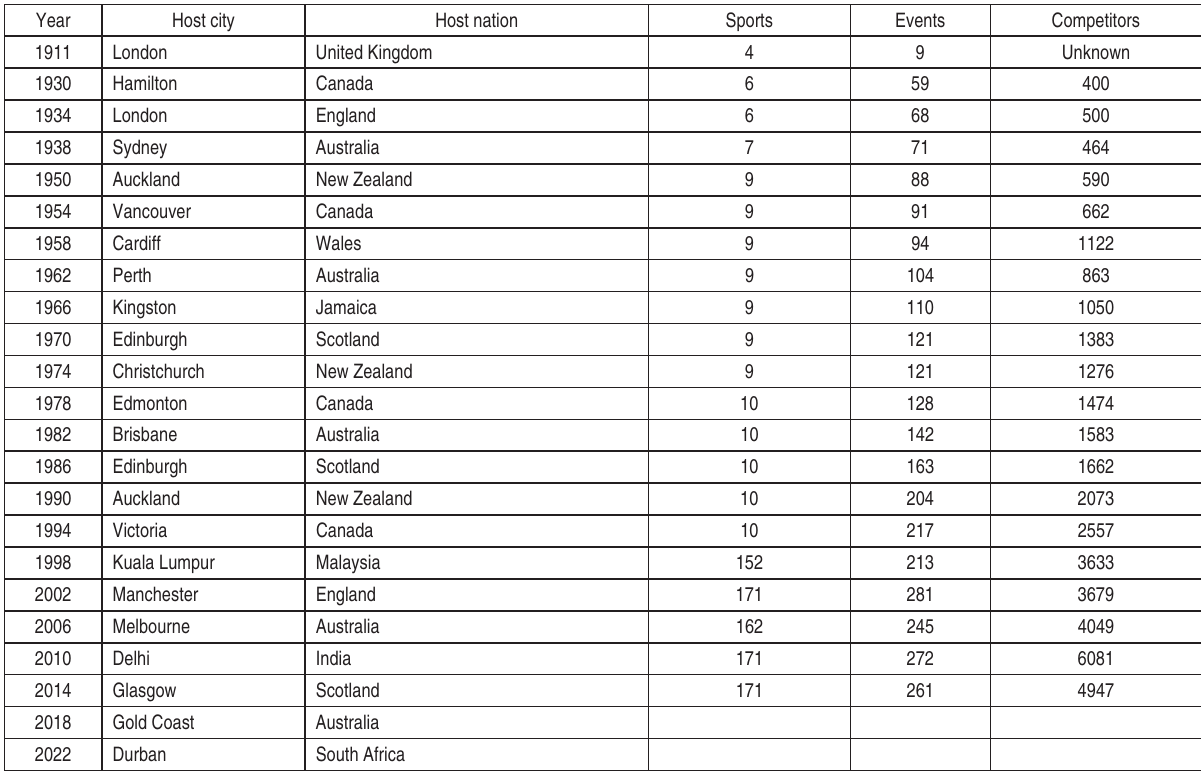
Table 1. The history of Commonwealth